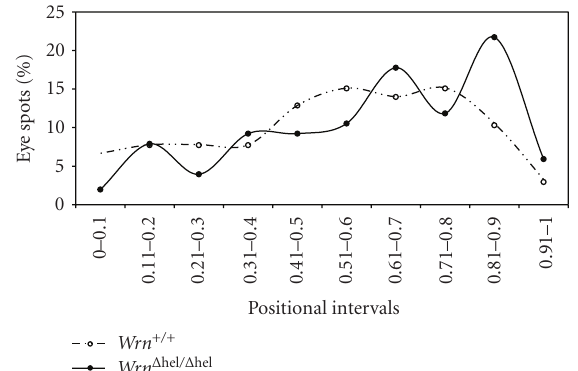
Figure 4: Positional distribution of all eye spots. WRN helicase does not a ff ect positional or pattern distribution ( P = . 22). Wild type (open circles with dash line) and Wrn Δ hel / Δ hel (closed circles with solid line)